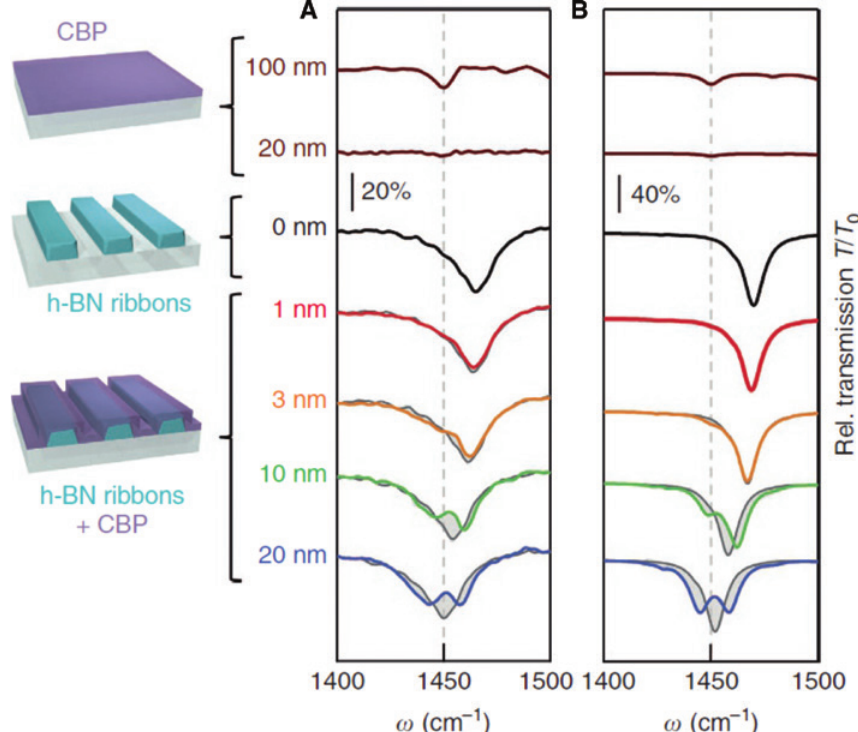
Figure 11: IR transmission spectra of h-BN ribbon arrays with differently thick CBP coating. (A) Experimental transmission spectra of a 20 × 20 μ m 2 size h-BN ribbon array with period D = 400 nm and ribbon width w = 158 nm. The thick black curve shows the spectrum of bare h-BN ribbons. As a guide to the eye, it is repeatedly shown (gray curves, shifted along the frequency axis) in the background of the spectra of the CBP-coated ribbon arrays. Red to blue curves show the spectra of CBP-covered h-BN ribbon arrays for increasing CBP thickness. The brown curves in the top part of the graph show the spectra of a 100- and 20-nm-thick bare CBP layer placed directly onto the substrate. (B) Simulated transmission spectra for a bare h-BN ribbon array (black curve, D = 400 nm, w = 167 nm) for a CBP-covered h-BN ribbon array [same color notation of (A)] and for a bare CBP layer (brown curves). The calculated spectrum for the bare ribbons is repeatedly shown in the background of the other spectra (gray curves, shifted along the frequency axis). The gray-shaded areas visualize the difference between the gray and colored spectra. Adapted with permission from